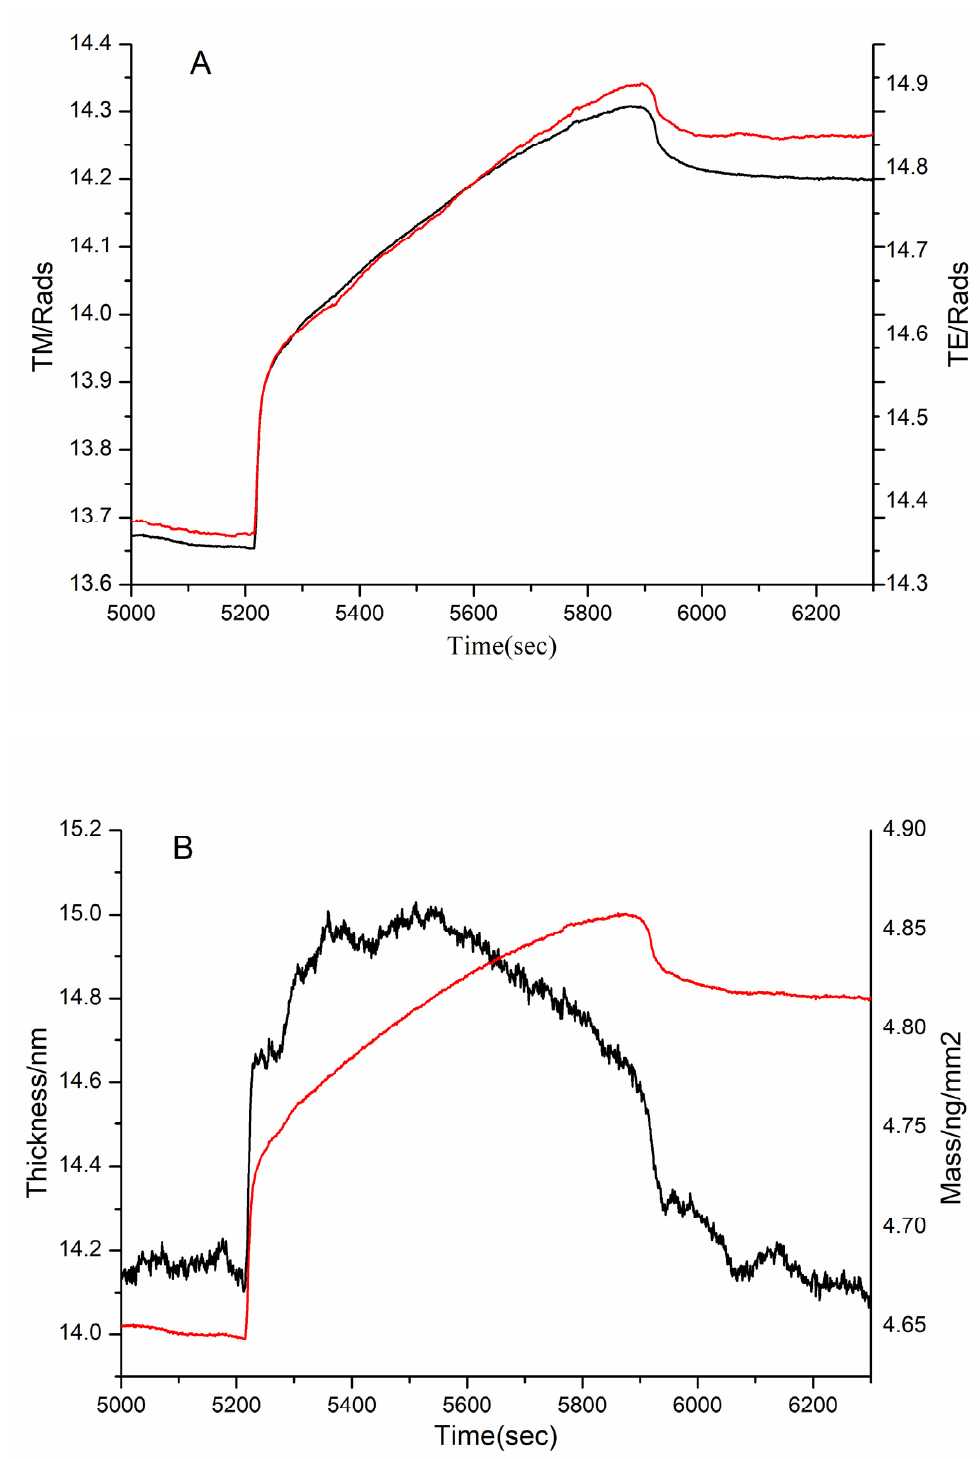
Figure 10. Adsorption of 3 kDa sample to immobilized FN on the chip surface as shown by ( A ) the measured TM (black line) and TE (red line) phase changes and ( B ) the resolved layer thickness (black line) and mass (red line).